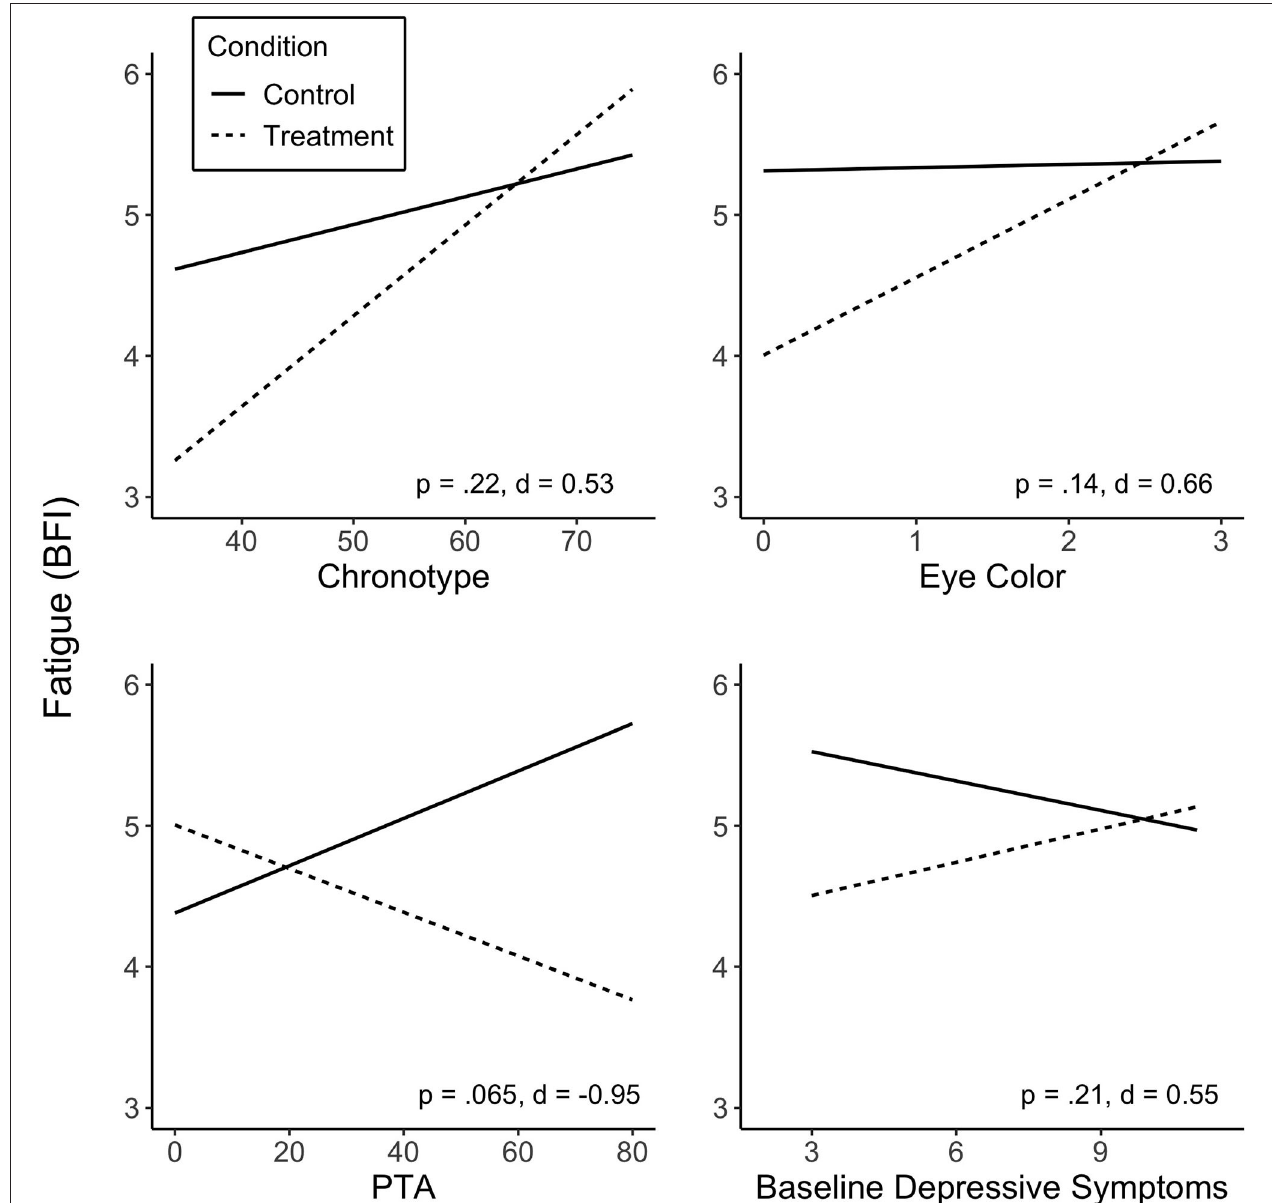
FIGURE 2 | Predicted values of fatigue (BFI) from chronotype (A) , eye color (B) , injury severity (PTA duration) (C) and baseline depressive symptoms (D) . Predictors did not significantly moderate treatment effect on fatigue, but showed medium and large effect sizes. Treatment sequences are combined in figures. Significance ( p ) and effect size (Cohen’s d ) represented are for predictor-treatment interaction. BFI score range 1–10; score of ≥ 4 suggests clinically significant